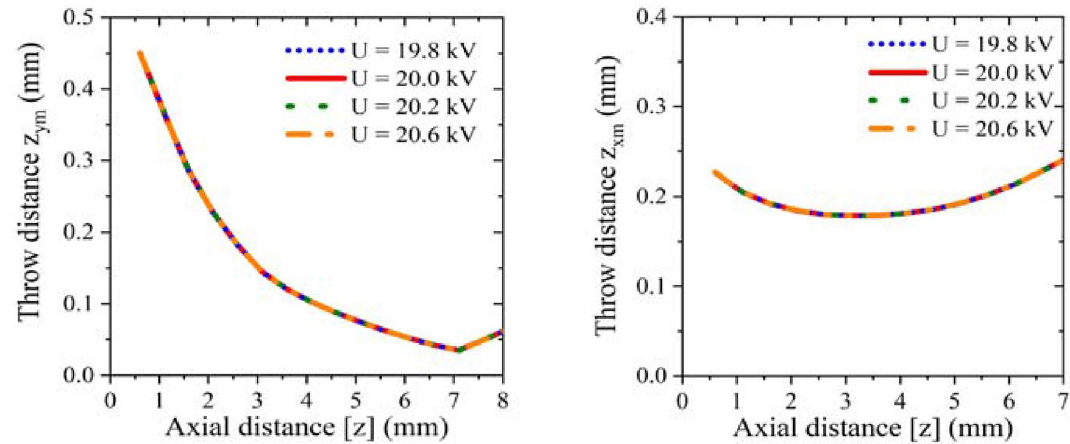
Figure 11. Effects of driven voltage fluctuations on beam envelope diagram in x-direction and y-direction